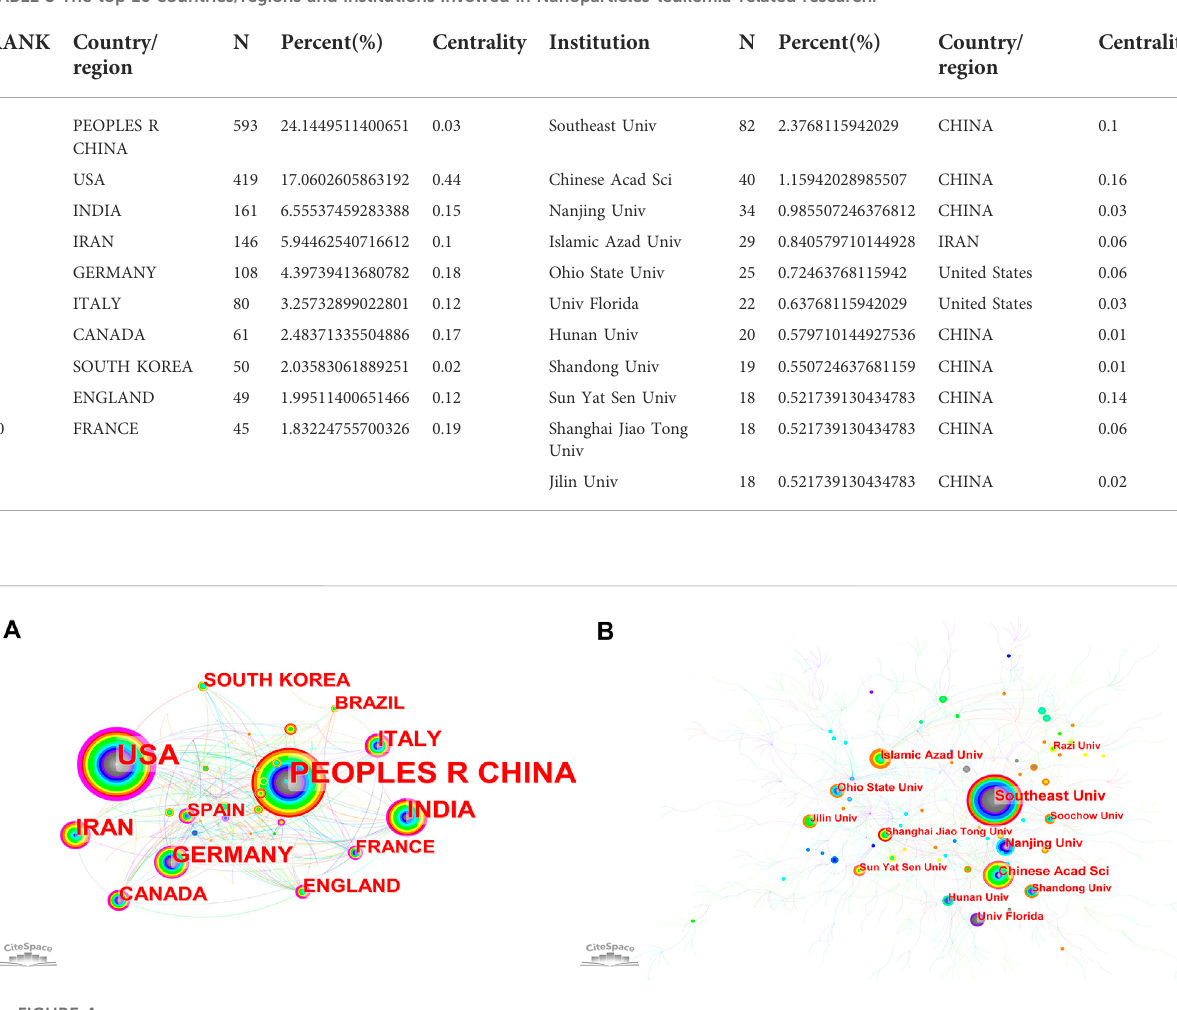
FIGURE 4 Theco-occurrencemapof (A) countries/regionsand (B) institutionsinNanoparticles-leukemiaresearch(T ≥ 18).Notes:Thenode ’ ssizere fl ects the co-occurrence frequencies, and the links indicate the co-occurrence relationships. The color of the node and line represent different years. Colors vary from grey to orange as time goes from 1999 to 2022; a node with a purple round means high betweenness centrality ( >